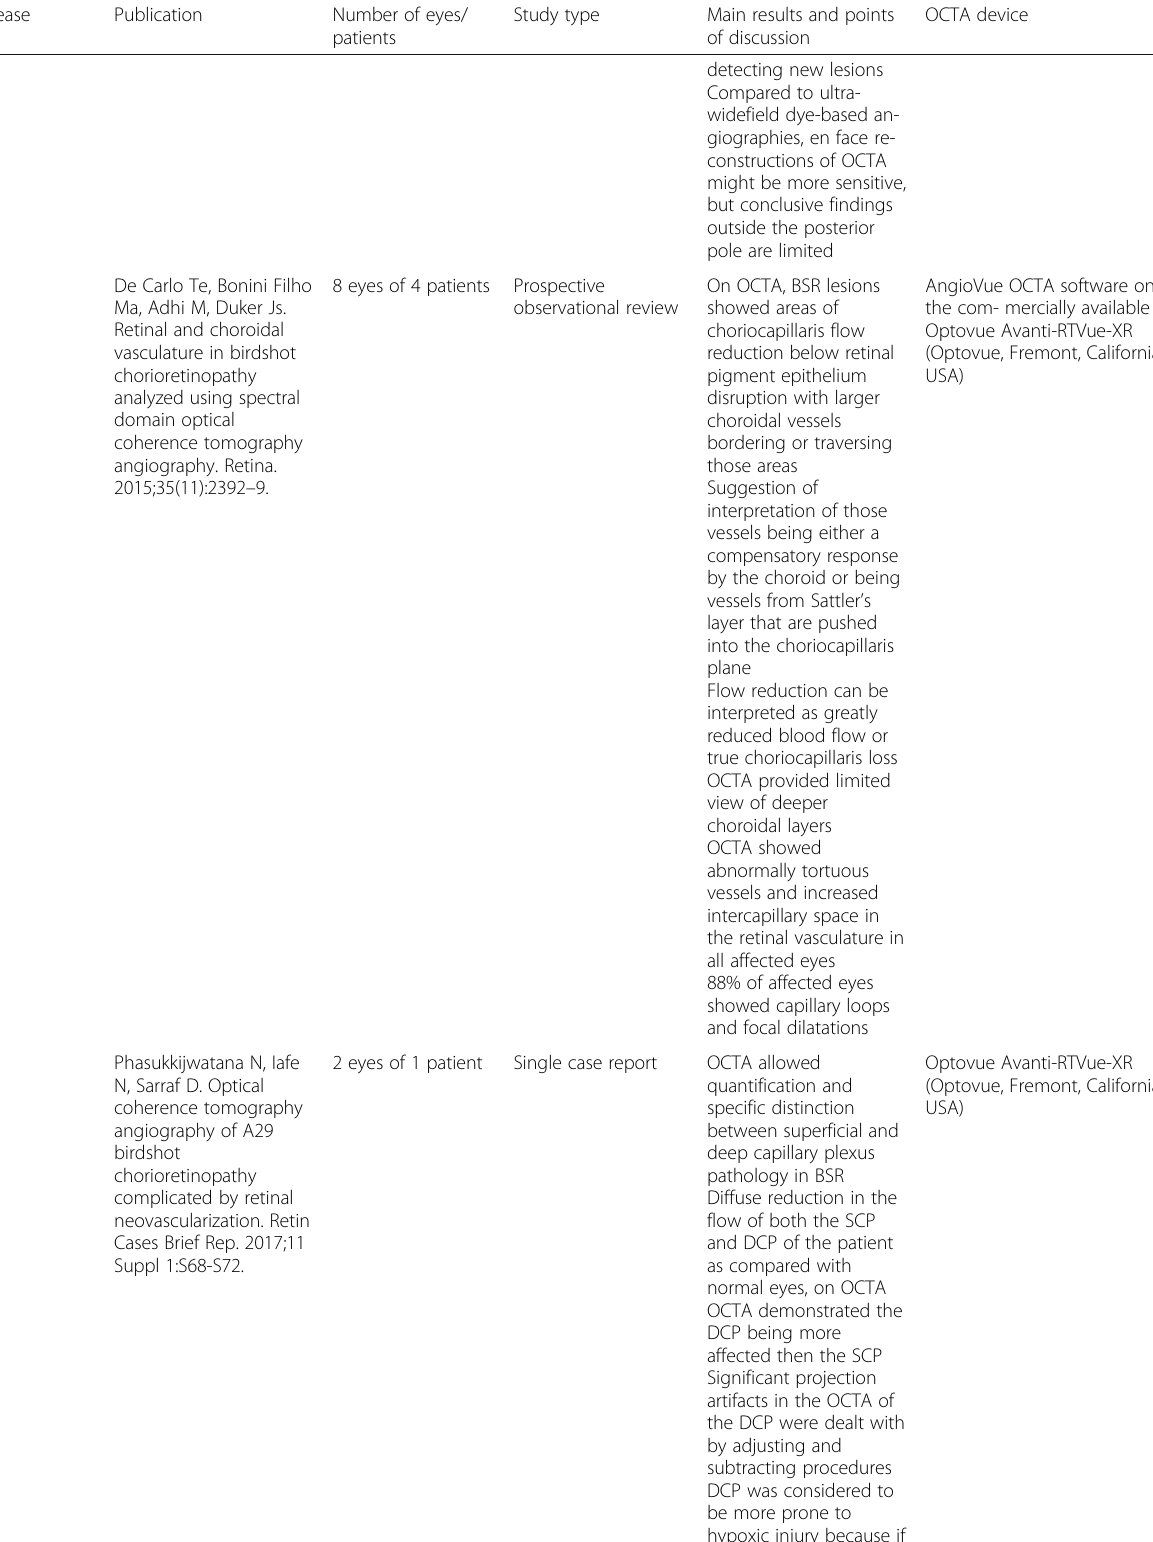
Table 1 Summary of publications on the implementation of OCTA in white dot syndromes (Continued)